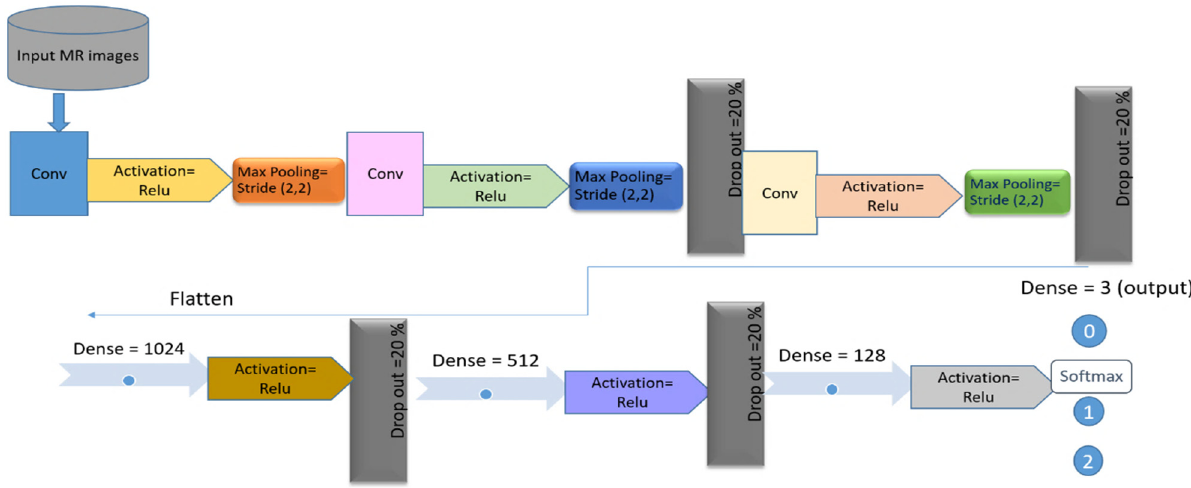
Figure 3. Customized convolutional neural network architecture with eleven layers for the prediction of anterior cruciate ligament tears.